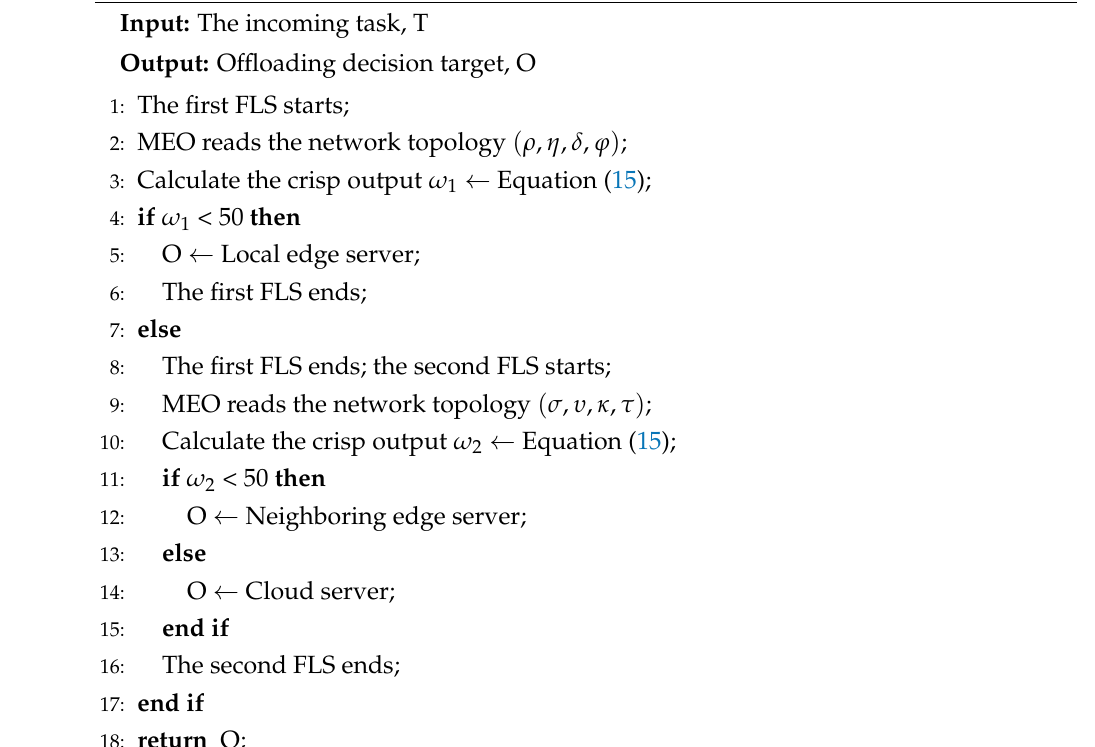
Algorithm 1 Two-Stage Fuzzy-Logic-Based Task Offloading